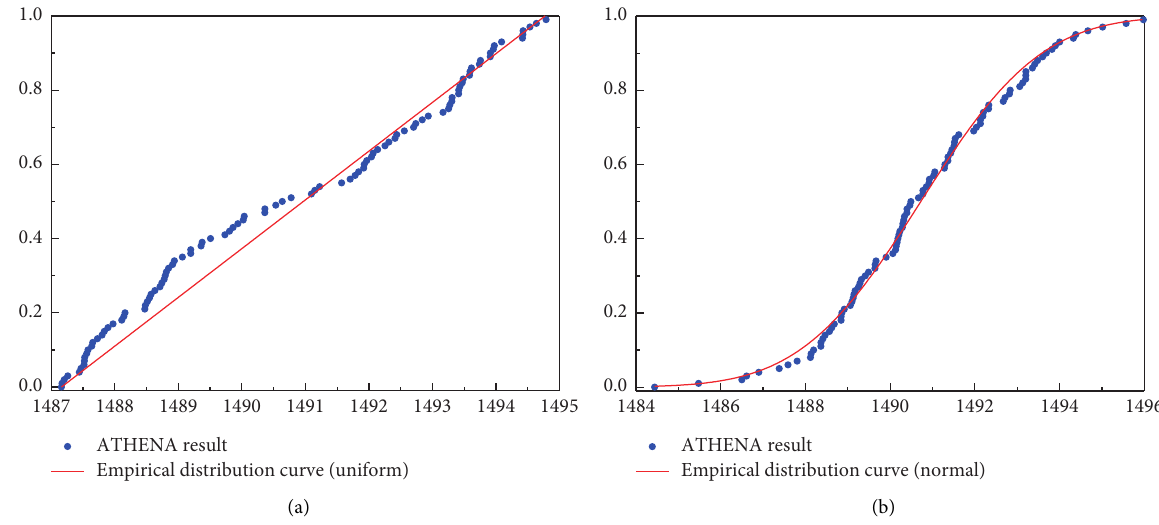
Figure 11: CDFs and fitted distribution results with input of different distributions. (a) RP with uniform distribution. (b) RP with normal distribution.